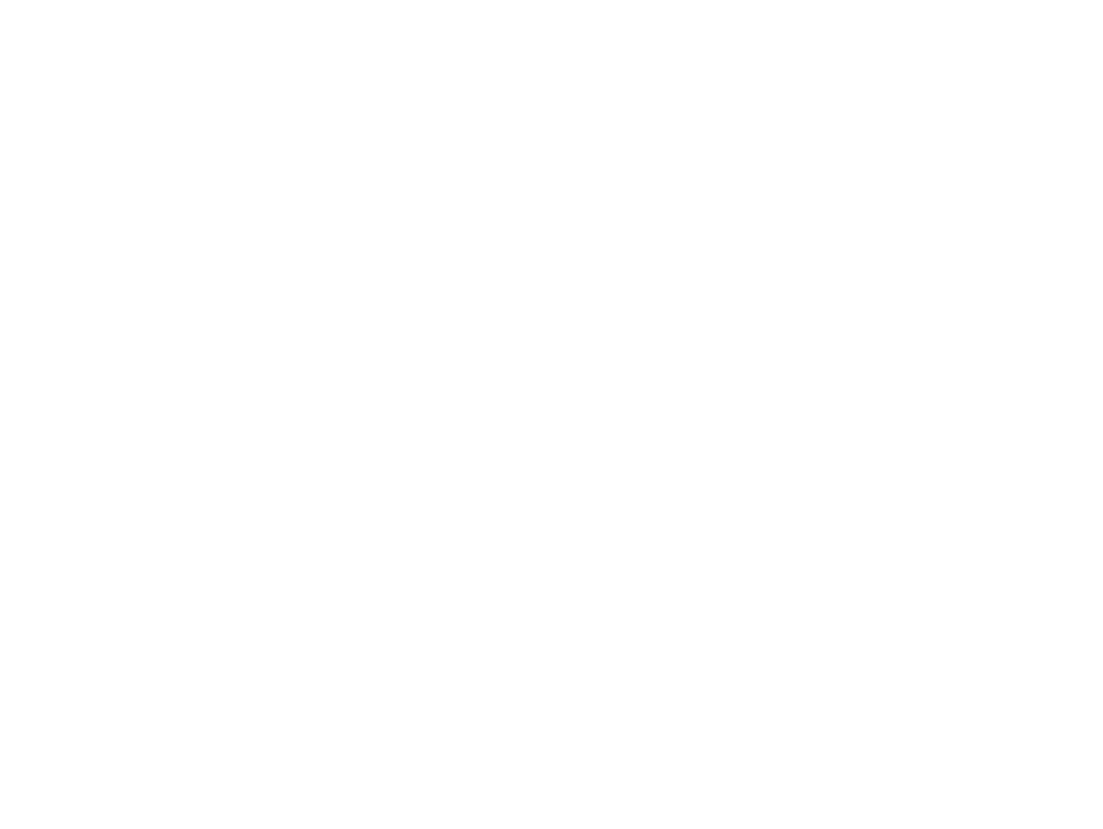
Frontiers in Environmental Science |